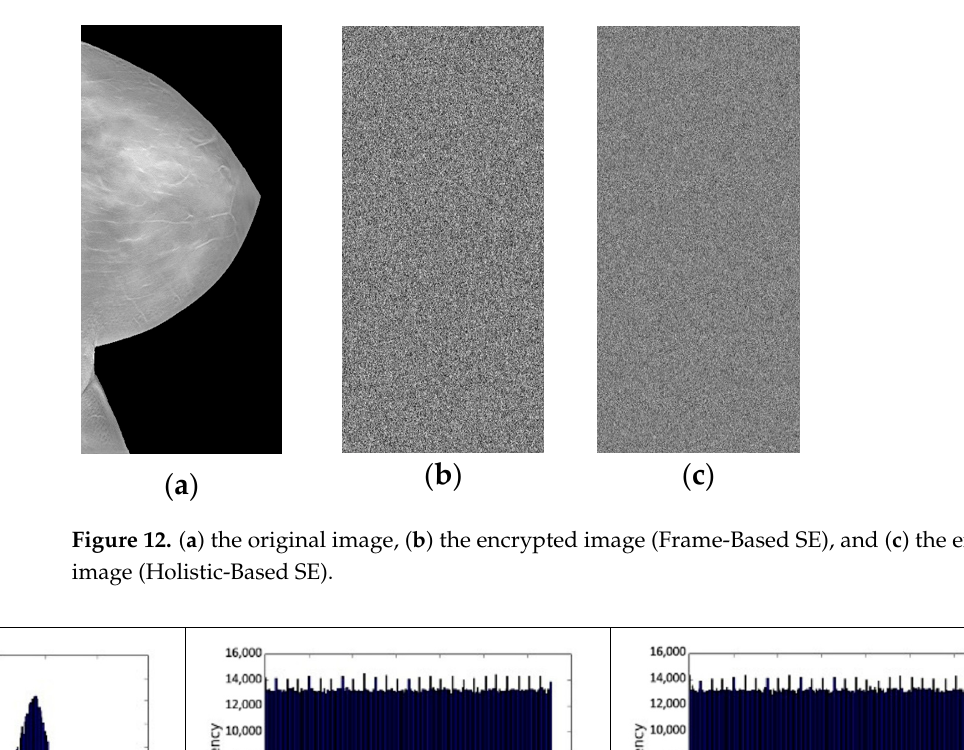
Figure 12. ( a ) the original image, ( b ) the encrypted image (Frame-Based SE), and ( c ) the encrypted image (Holistic-Based SE).